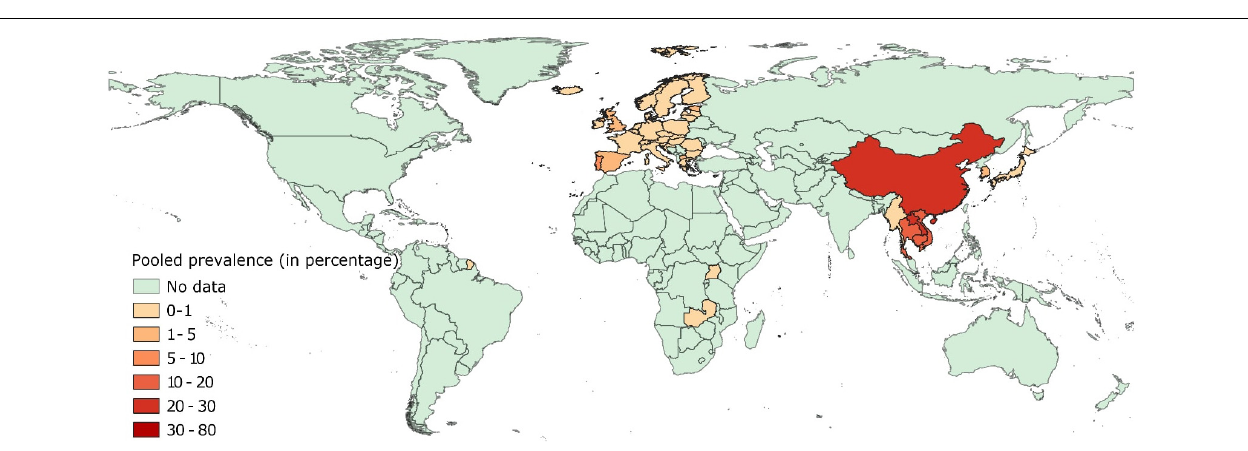
FIGURE 3 | Global distribution of colistin resistance in E. coli isolates collected from healthy